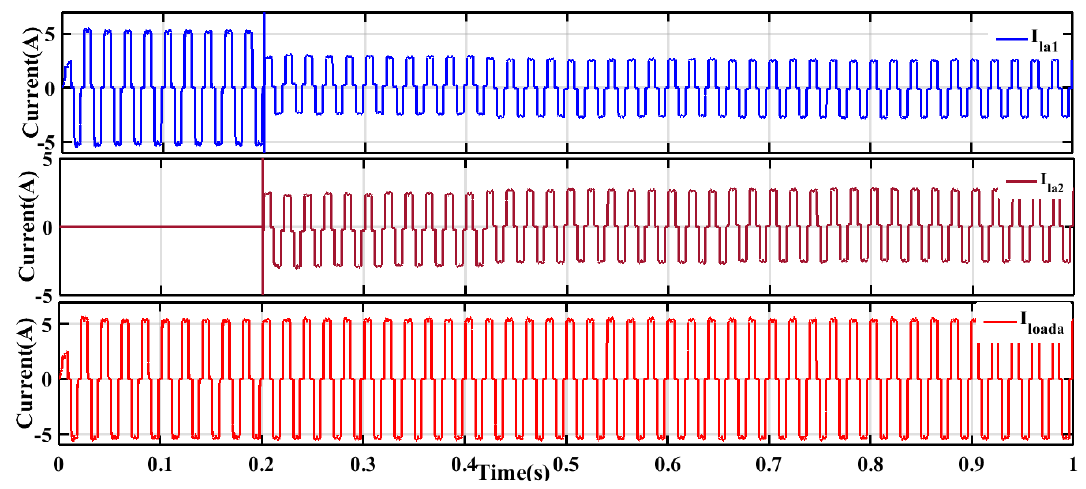
Figure 15. Transient operation of inverter with nonlinear load.